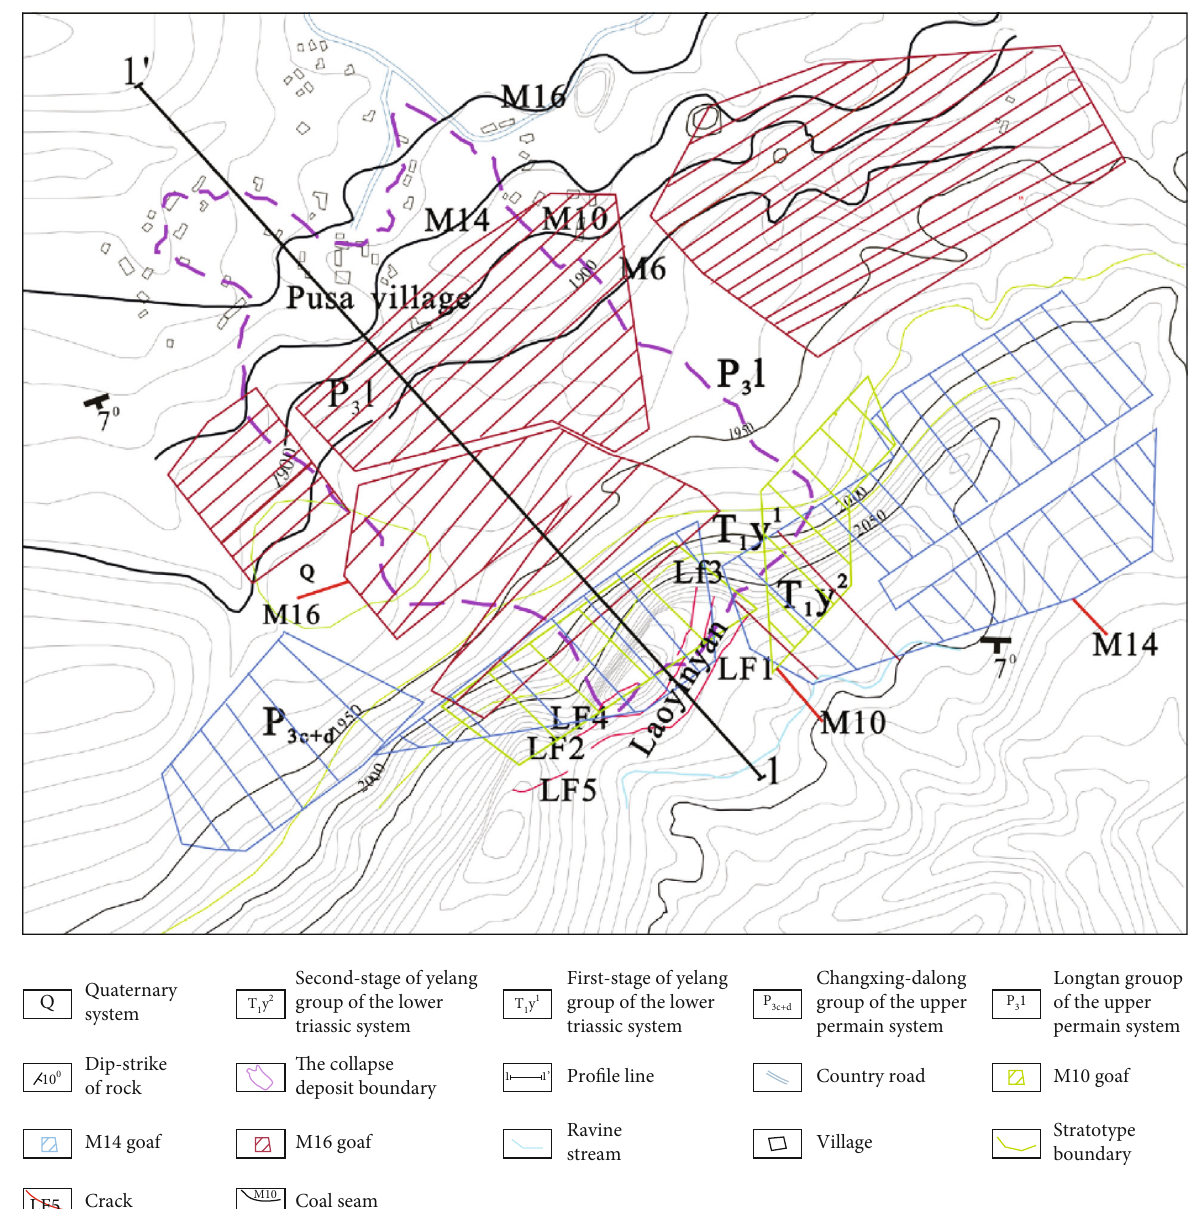
Figure 2: Regional topographic and geological map of Pusa